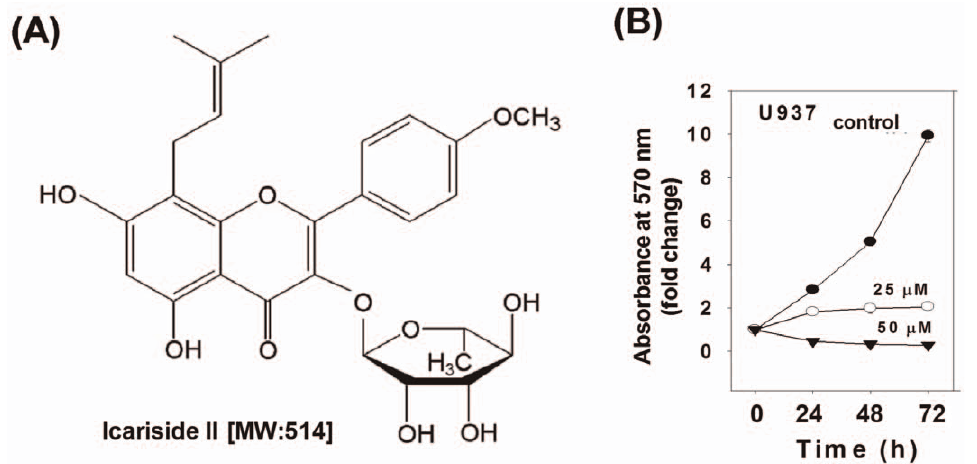
Figure 1. Effect of Icariside II on the proliferation of U937 cells. (A) Chemical structure of Icariside II. (B) Cells were treated with Icariside II (0, 25 or 50 m M) for 0, 24, 48 or 72 h and subjected to MTT assay to analyze cell proliferation. Data are presented as means 6 SD for triplicate experiments.